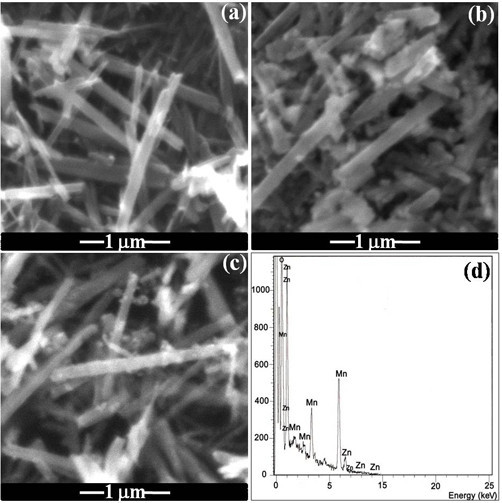
The SEM images of different samples: (a) α-MnO2 nanorods; (b) α-MnO2/Zn(OH)2 nanorods; (c) the ZnMn2O4 nanorods calcined at 650°C; and (d) EDS spectrum of the ZnMn2O4 nanorods calcined at 650°C.